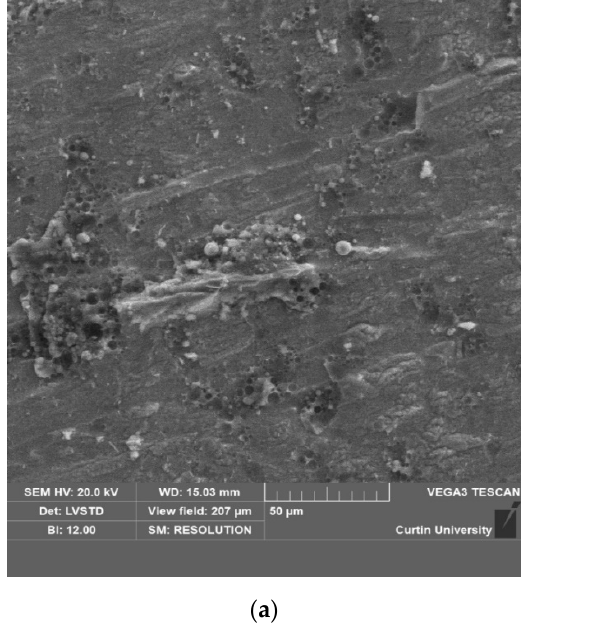
Figure 13. SEM images of surface of AMF fibers in geopolymer composites at ( a ) ambient temperature ( b ) 800 °C.